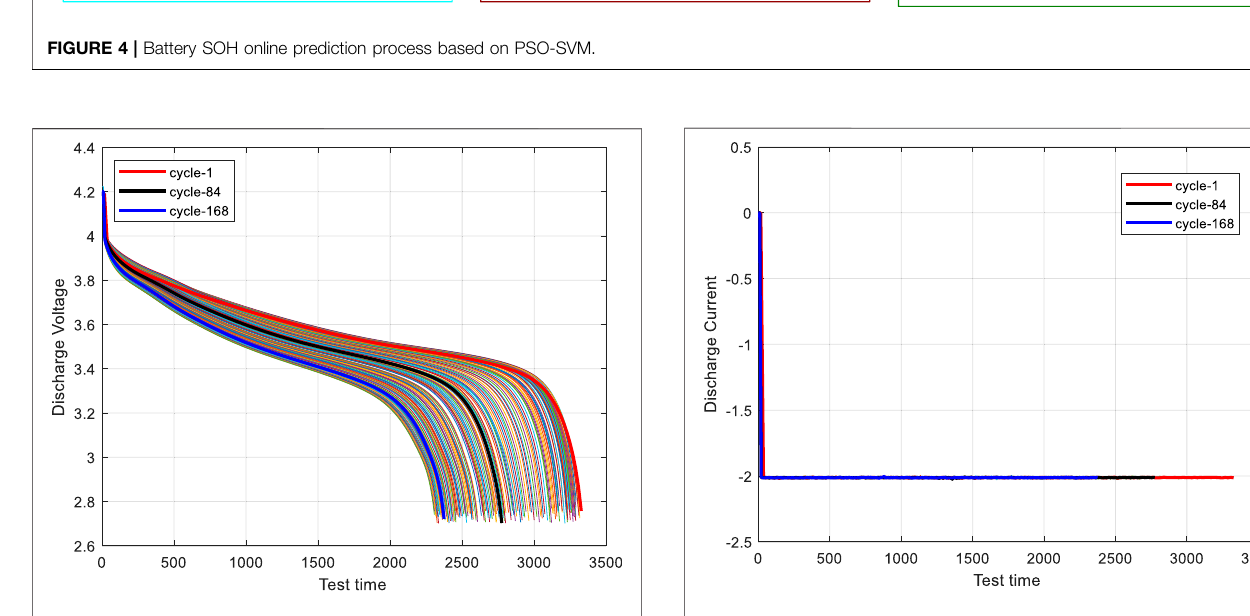
FIGURE 5 | The discharge voltage curve of battery #2. FIGURE 6 | Discharge current diagram of battery